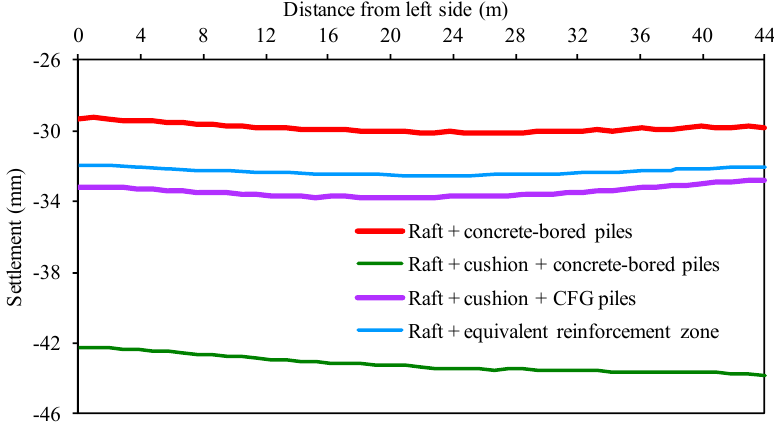
Figure 11. Settlement curve of the longitudinal central section of the raft under the four simulation schemes.